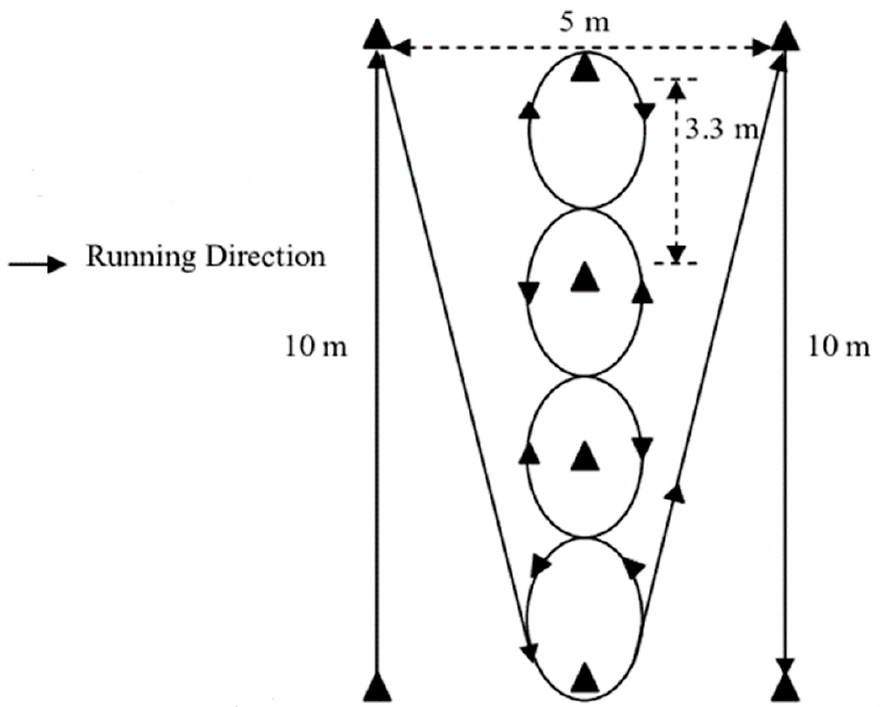
Figure 1. Dimensions and running direction for the Illinois Agility Test.